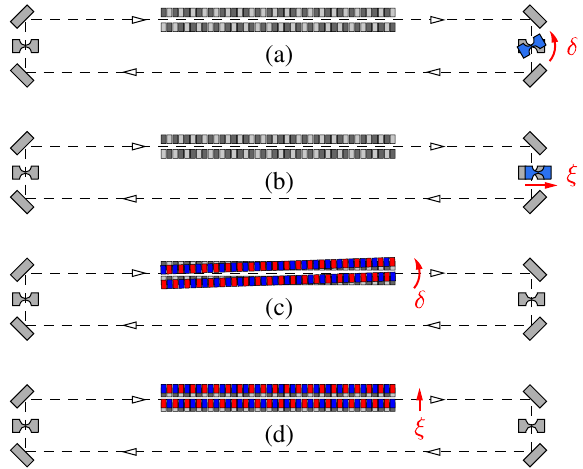
FIG. 8. Additional misalignment scenarios. (a) Lens L 1 with yaw angle error δ or (b) spatial error ξ ; (c) undulator source with yaw angle error δ or (d) position misalignment ξ